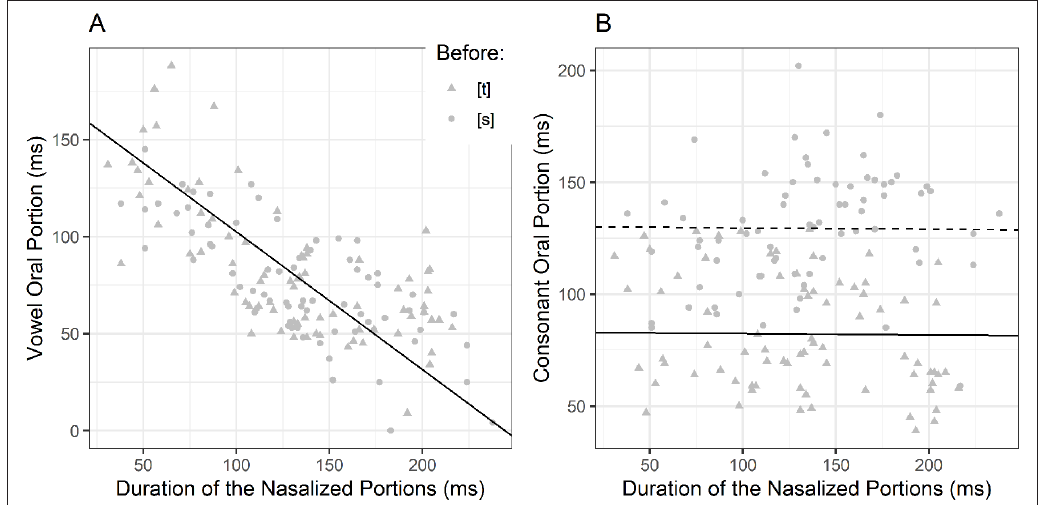
Figure 9: Vowel oral portion (A) and consonant oral portion (B) as a function of the duration of the nasalized portions. Lines represent how the duration of the vowel or consonant oral por- tion change as a function of the duration of the nasalized portions – in (A), solid line for both [t, s] because there was no difference between contexts; in (B), solid line for [t] and dashed line, for